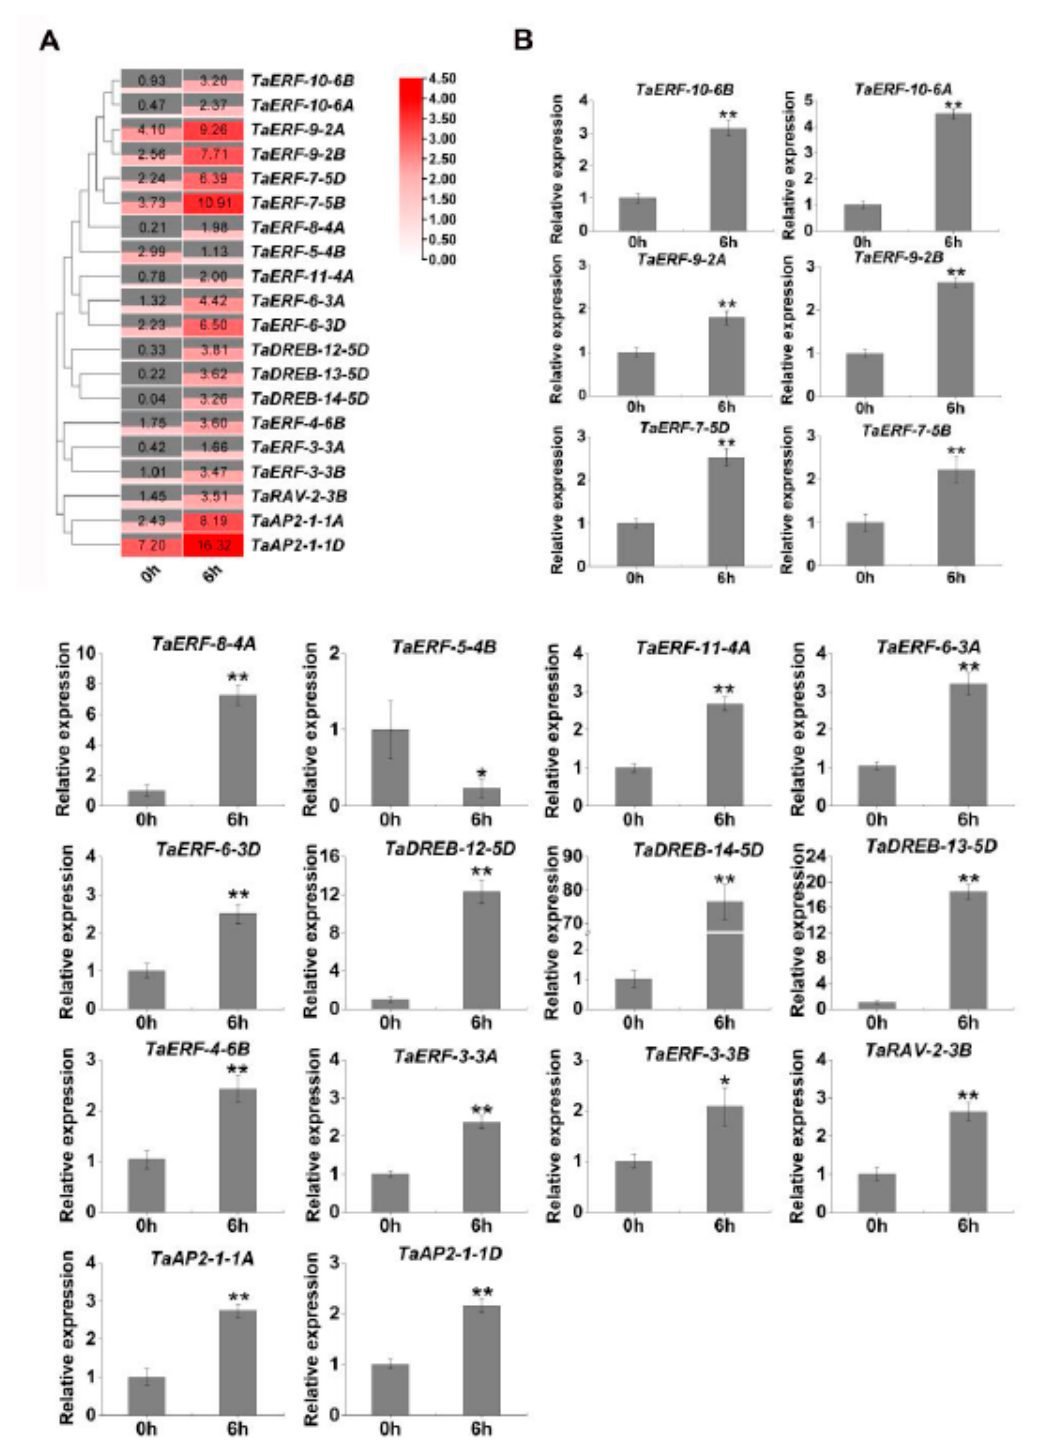
Figure 5. RNA-seq data analysis and qRT-PCR verification. ( A ) Heatmap of 20 AP2/ERF gene members in the leaves of JW1 before and after drought stress. The changes in expression levels are visually reflected in the heatmap with the gradient color white (low)/red (high). The heatmap was created using TBtools software. Data are the mean fragments per kilobase million (FPKM) values in RNA-seq data, which reflect the relative transcript abundance; ( B ) Expression profiles of 20 TaAP2/ERF genes under drought stress. Columns represent the results of qRT-PCR verification. Standard deviations are indicated by error bars (the mean ± SD, and n = 3), and significantly different values are indicated asterisks (ANOVA, * p < 0.05; ** p < 0.01).